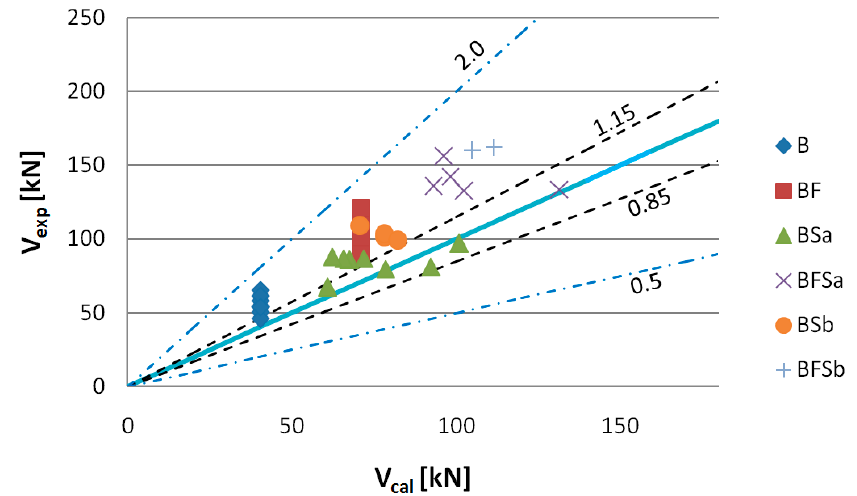
Figure 26. Values of experimentally fixed ( V exp ) versus computational ( V cal ) shear capacity deter- mined according to Model Code 2010 (measured angle θ ).